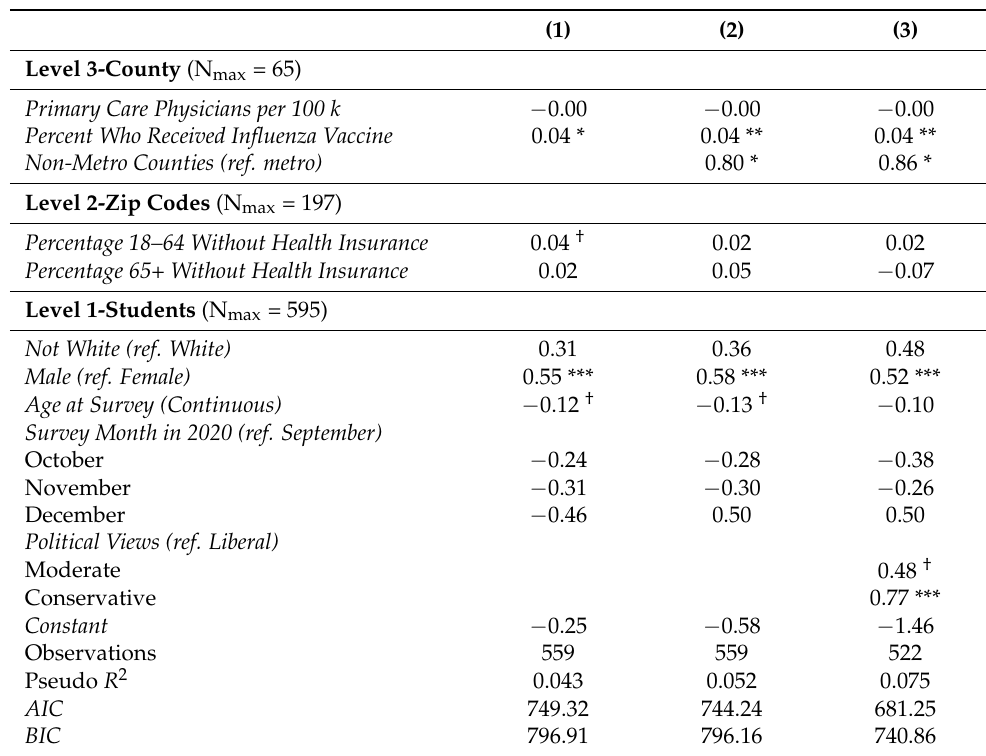
Table 5. Multi-Level Logistic Regressions Predicting the Log Odds of Influenza Vaccine Hesitancy among